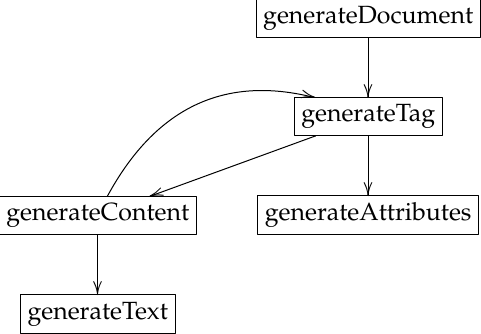
Figure 6. XML document generation template in ACCELEO.